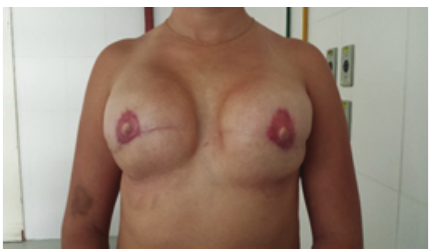
Figure 2: Frontal view showing the outcome of the third and final plastic surgery procedure in which the nipple-areola complex was reconstructed